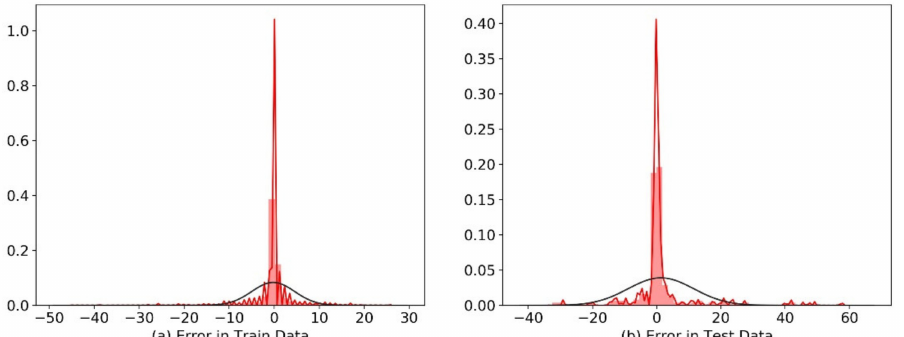
Figure 11. Distribution of error for train and test dataset, Bayesian Neural Network. Black outline denotes the theoretical normal distribution and the red color represents the distribution of the residual error.